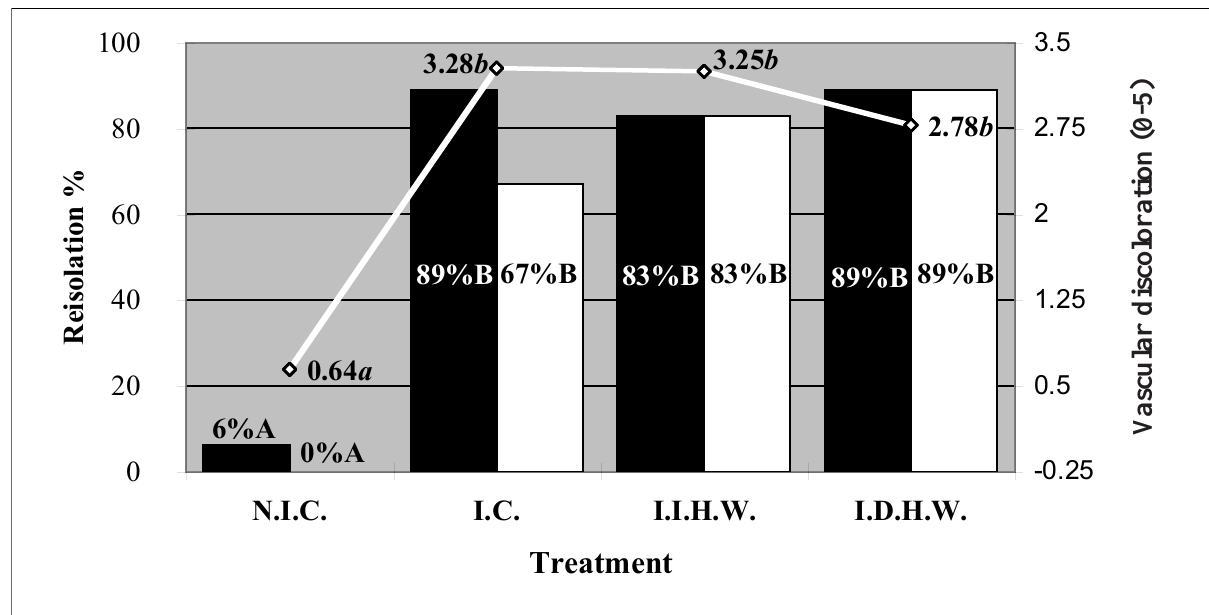
Fig. 3. Hot water treatment effect on colonization by both Phaeoacremonium inflatipes (white histogram) and Phae- moniella chlamydospora (black histogram) and vascular discoloration (line) on artificially inoculated grapevines ( Vitis vinifera cv. Thompson Seedless). N.I.C., cuttings inoculated with sterile water only and not treated in hot water; I.C., cuttings inoculated with Pa. chlamydospora and Pm. inflatipes and not treated in hot water; I.I.H.W., cuttings inoculated with Pa. chlamydospora and Pm. inflatipes and immediately treated in hot water; I.D.H.W., cuttings inoculated with Pa. chlamydospora and Pm. inflatipes and treated in hot water 24–48 hours later. Means followed by the same letter are not significant different according to Duncan’s Multiple Range Test ( P